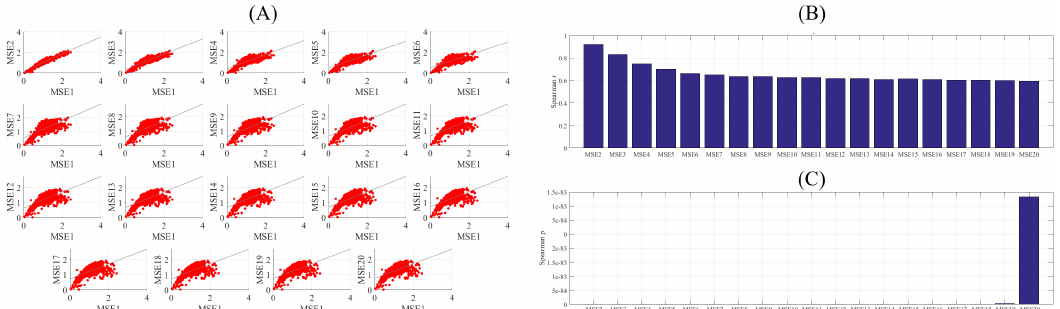
Figure A24. Neutral affect’s Spearman correlations between MSE1 versus MSE2–MSE20. ( A ) Scatter plots of MSE1 versus MSE2–MSE20 ( B ) Spearman correlations associated with MSE2–MSE20 and MSE1 ( C ) Spearman correlations’ p-values associated with MSE2–MSE20 and